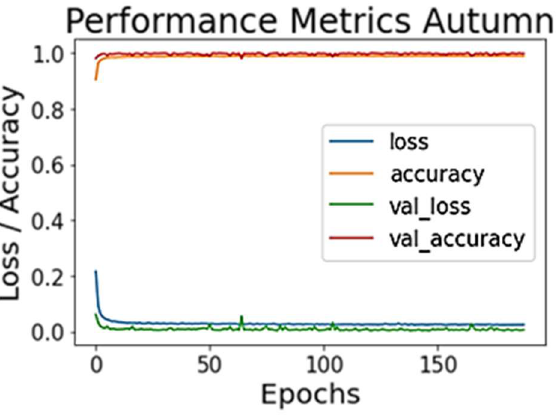
Figure 13. The loss/accuracy performance of the deep neural classifier for the Autumn season. An early stopping criterion interrupted the training after 189 epochs.